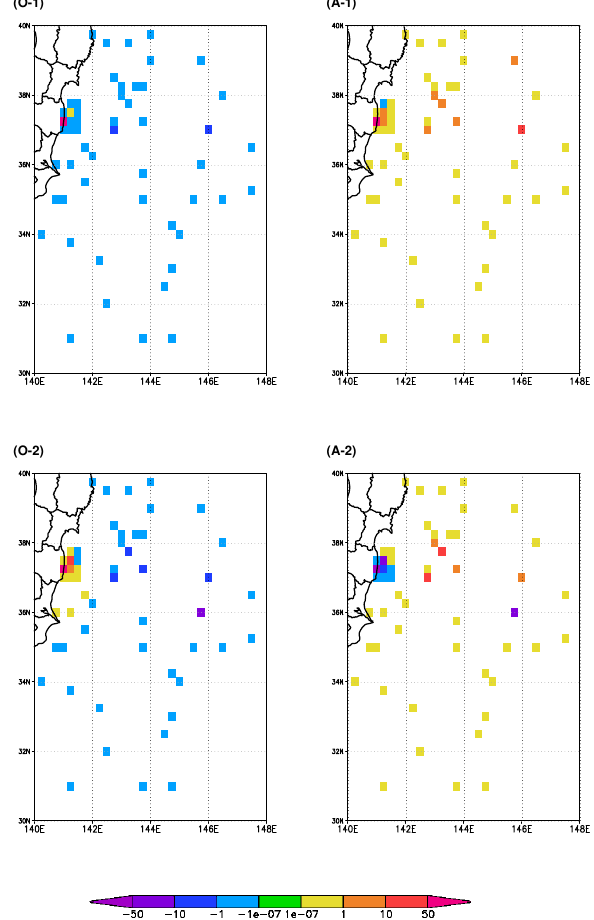
Fig. 6. Contribution rates (in %; Eq. 9) averaged in 1 / 4 ◦ × 1 / 4 ◦ Figure 6 grids. (O-1) The ocean parameter in the JCOPE-T-2-C case. (A-1) The atmospheric parameter in the JCOPE-T-2-case. (O-2) As in (O- 1) , except for the JCOPE2 case. (A-2) As in (A-1) , except for the JCOPE2